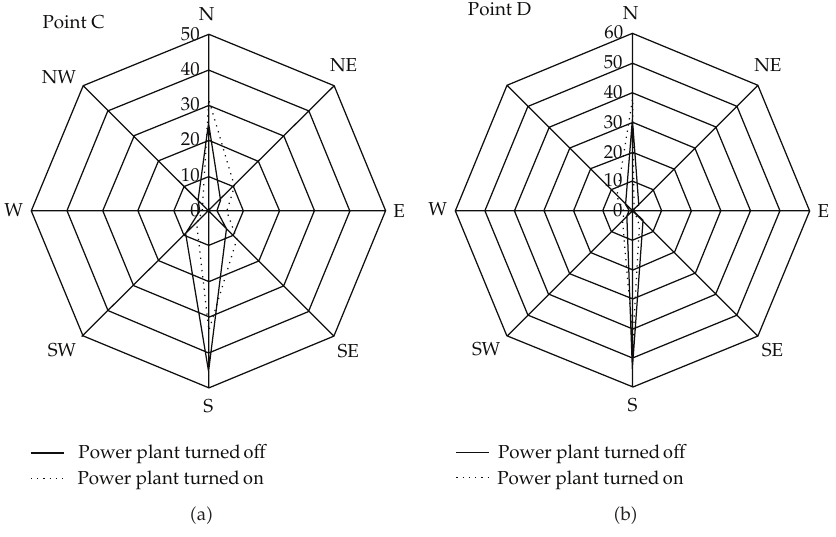
Figure 20: Directional frequency distribution in points C and D obtained in the simulation with the power plant and without the power